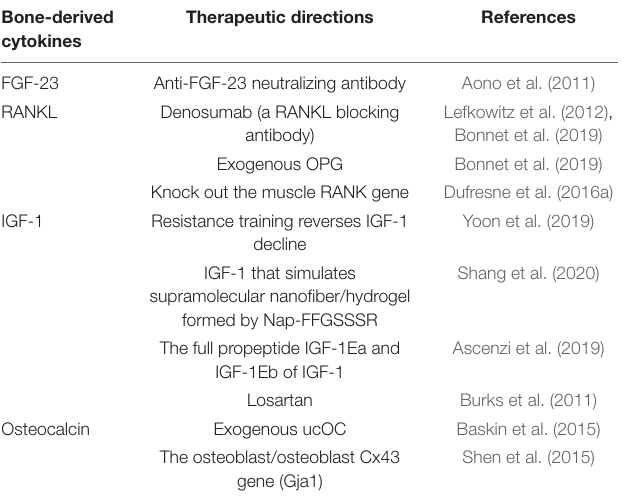
TABLE 1 | Therapeutic directions for sarcopenia in the future.